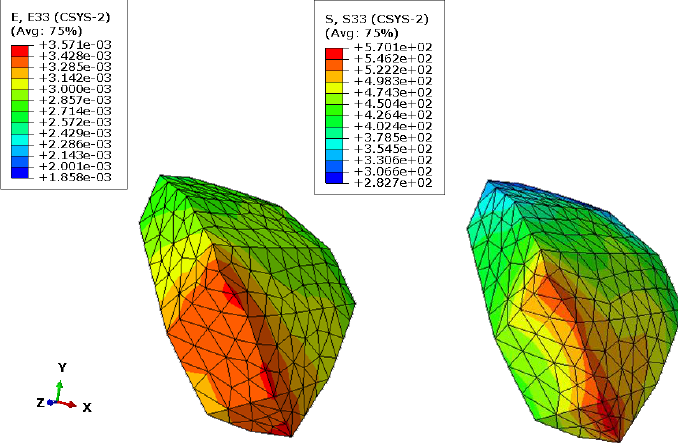
Figure 7. Stress and strain distribution in loading direction for a specimen with 49 grains and random orientation at 0.25% total strain. An anisotropic elasticity model of IN 738 LC at 850 °C was applied.